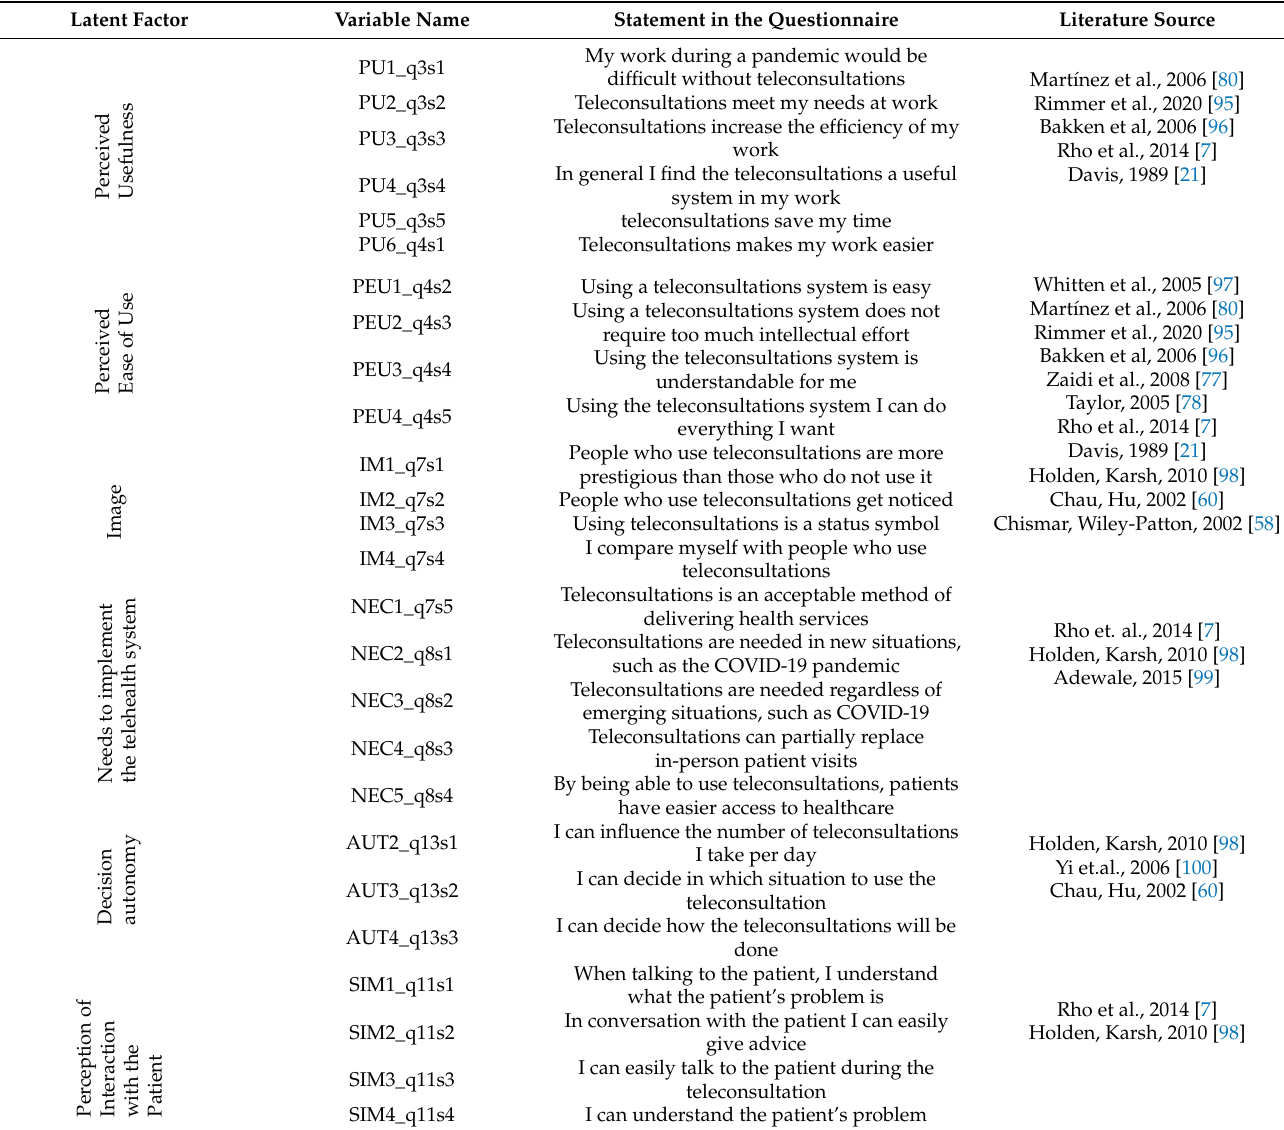
Table 1. Statements used in the questionnaire